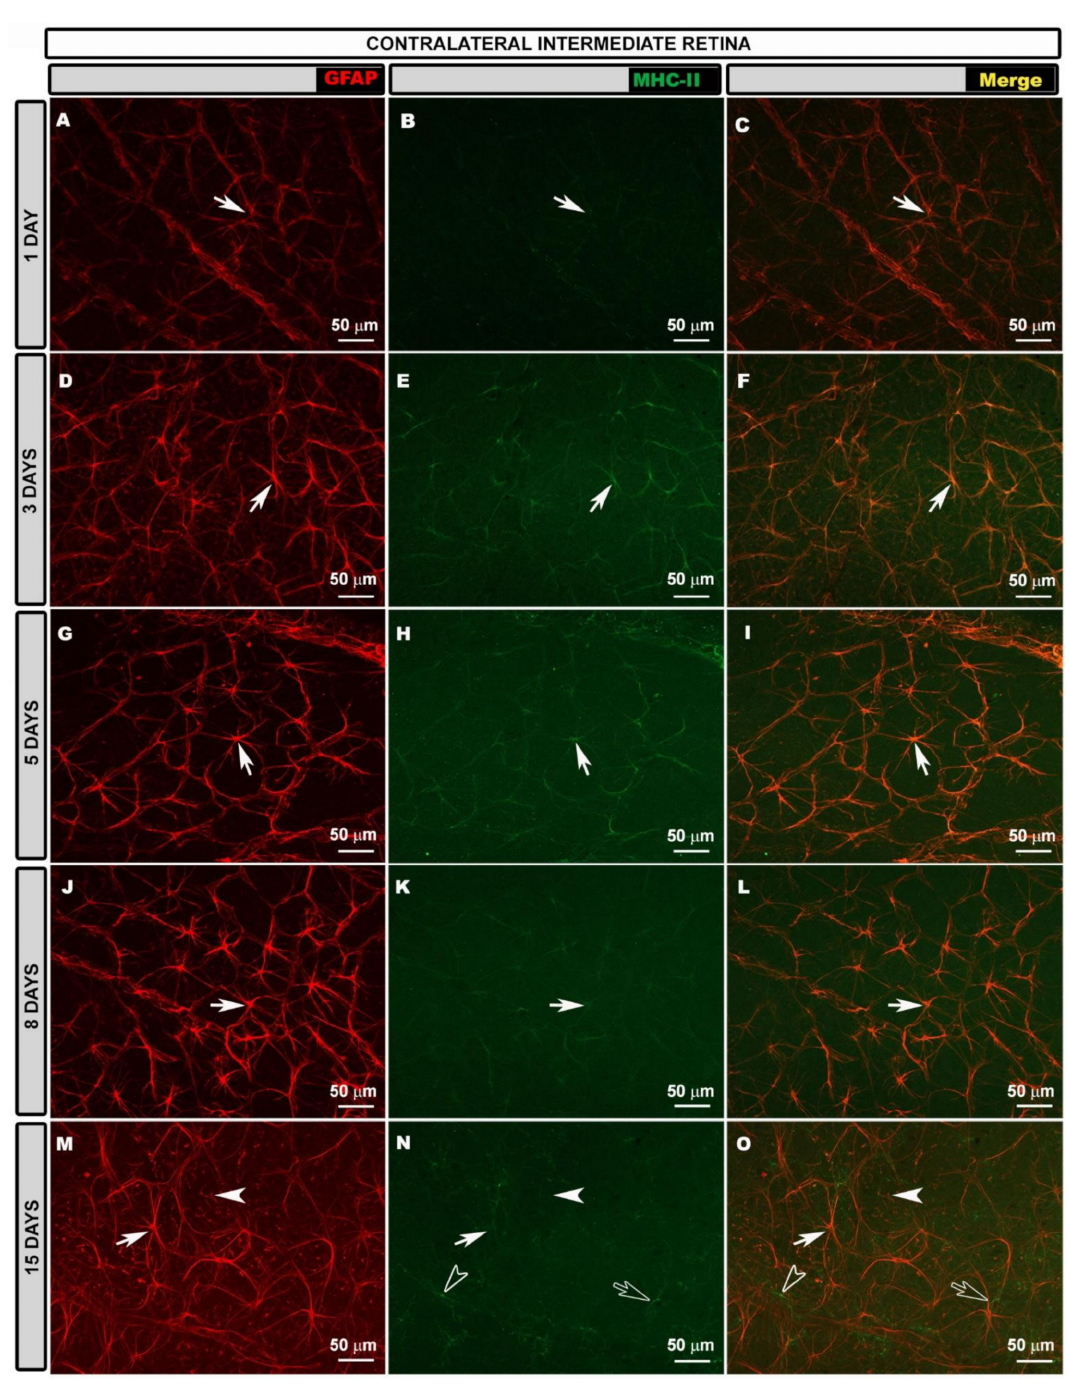
Figure 2. Retinal whole-mount. Double immunostaining for GFAP (red) and MHC-II (green) at different time points after OHT induction in contralateral eyes in the intermediate retina. GFAP- labeled astrocytes are shown at different time points ( A , D , G , J , M ). In the intermediate retina of contralateral eyes, MHC-II expression by astrocytes (arrow) was increased relative to that in areas near the OD at all time points (1 ( B , C ); 3 ( E , F ); 5 ( H , I ); 8 ( K , L ); and 15 ( N , O ) days) after OHT induction. At 15 days, microglia (hollow arrow) and end feet of Müller glia (arrowhead) also showed MHC- II immunolabeling. Images show perivascular microglia (hollow arrowhead) with high MHC-II expression ( N , O ). GFAP: glial fibrillary acidic protein; MHC-II: major histocompatibility complex class II; OHT: ocular hypertension; OD: optic